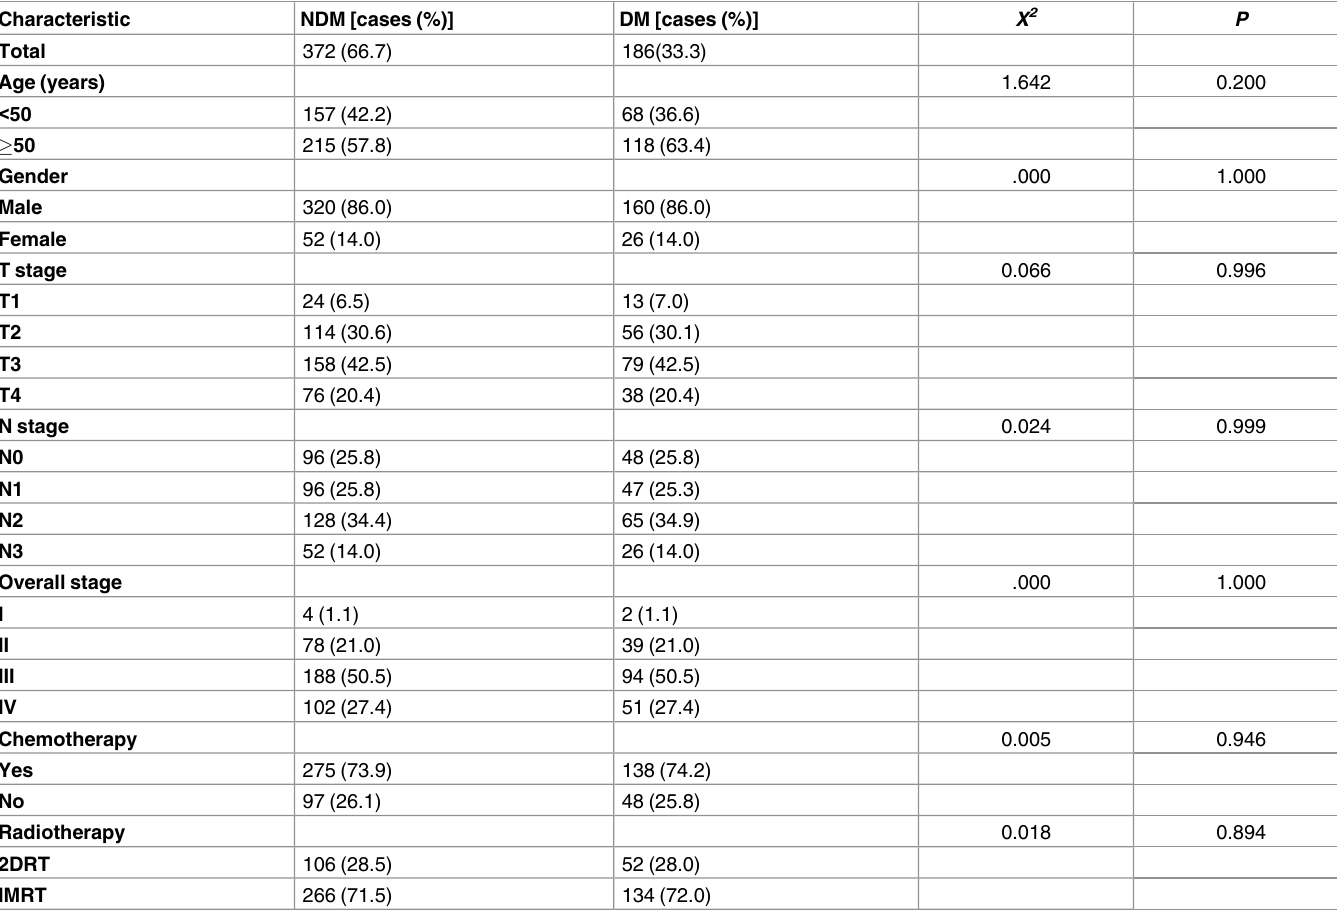
Table 1. Characteristics of the 558 patients with